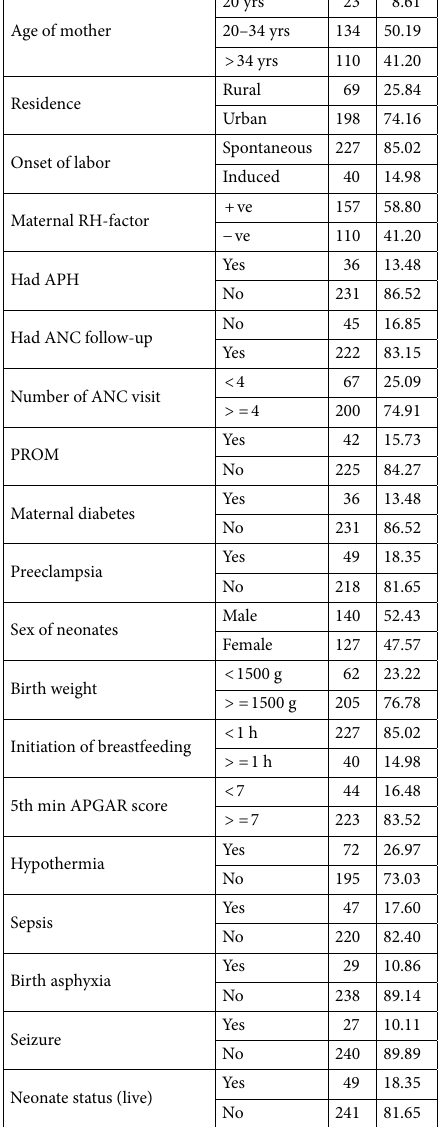
Table 1. Sociodemographic and obstetric characteristics of mothers and preterm neonates at Debre Tabor Comprehensive Specialized Hospital, Ethiopia, in 2021. APH, Antepartum Hemorrhage; ANC, Ante-natal care; APGAR, Appearance, Pulse, Grimace, Activity, and Respiration; DM, Diabetes mellitus; PROM, Premature rupture of membranes; RH,